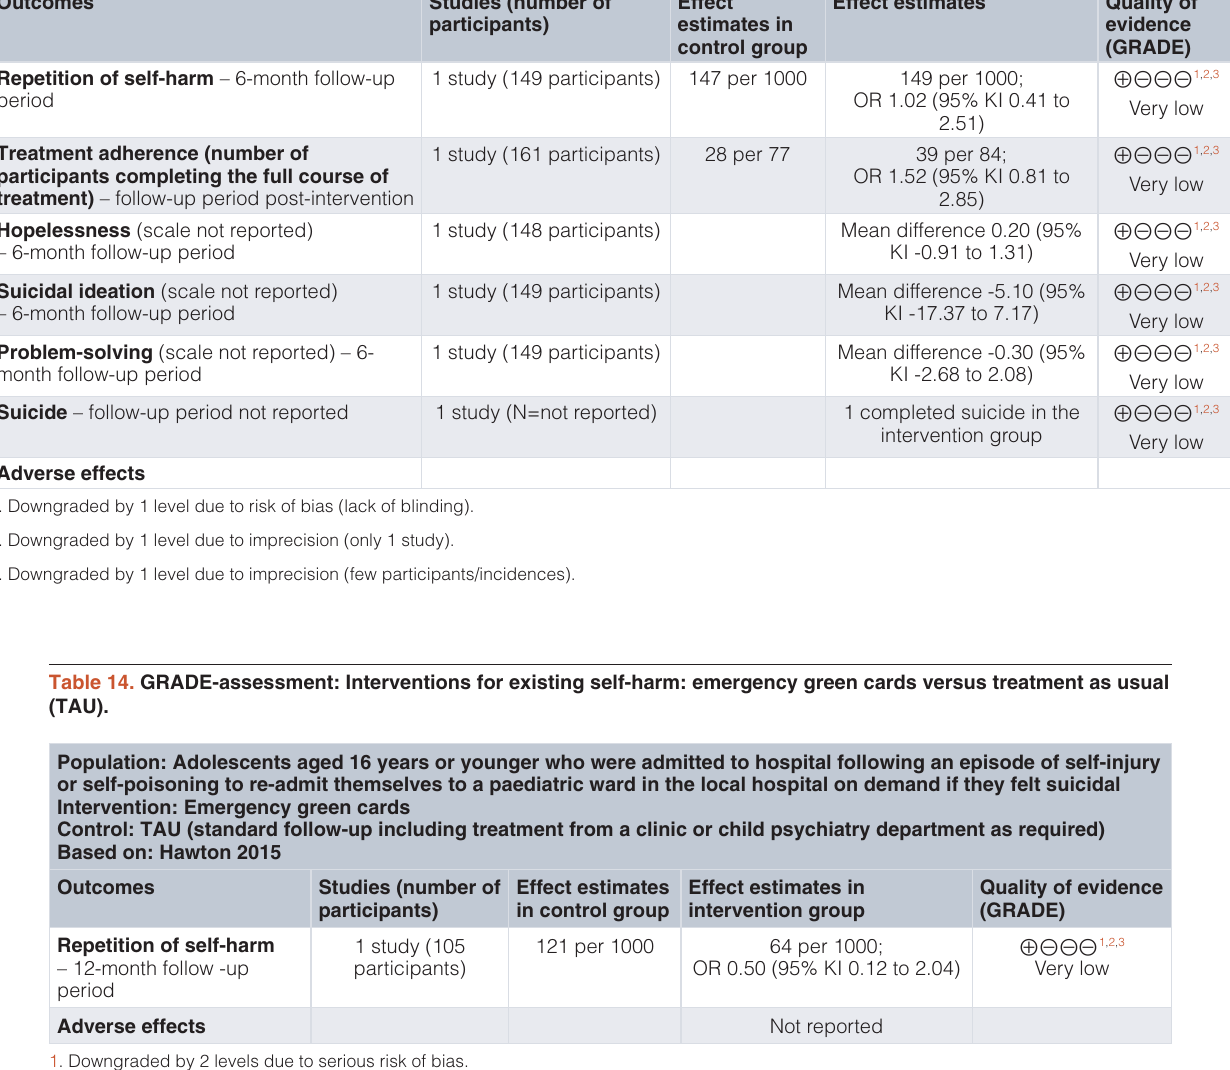
Table 13. GRADE-assessment: Interventions for existing self-harm: home-based family intervention versus treatment as usual (TAU). Population: Adolescents aged 16 years or younger referred to child and adolescent mental health services following an episode of self-poisoning irrespective of intent Intervention: Home-based family interventions plus TAU Control: